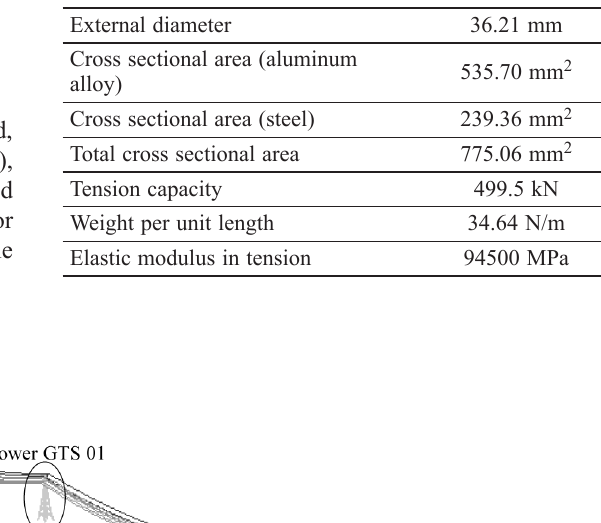
Table 3. Properties of the AACSR 535/240 conductor cable